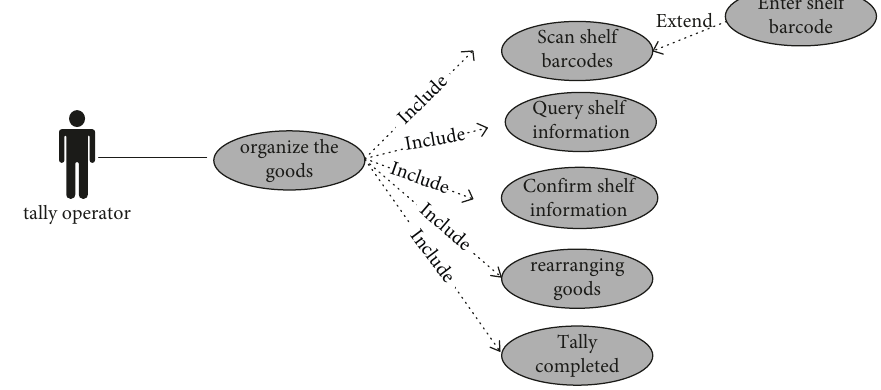
Figure 5: Tally use case diagram. Table 3: Tally use case table. Table 4: Outbound use case